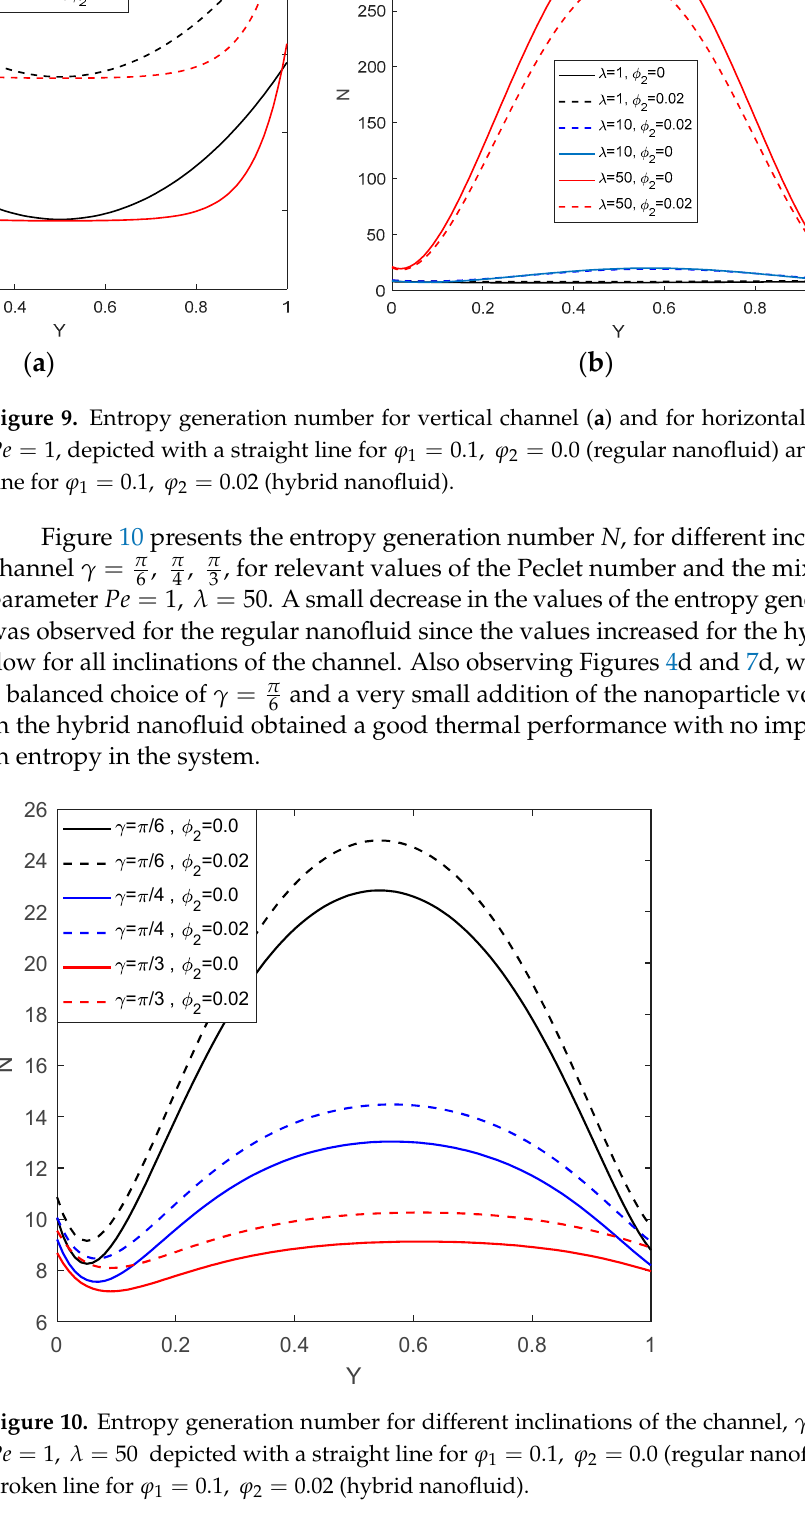
Figure 10. Entropy generation number for different inclinations of the channel, γ = π Pe = 1, λ = 50 depicted with a straight line for ϕ 1 = 0.1, ϕ 2 = 0.0 (regular nanofluid) and with a broken line for ϕ 1 = 0.1, ϕ 2 = 0.02 (hybrid nanofluid).